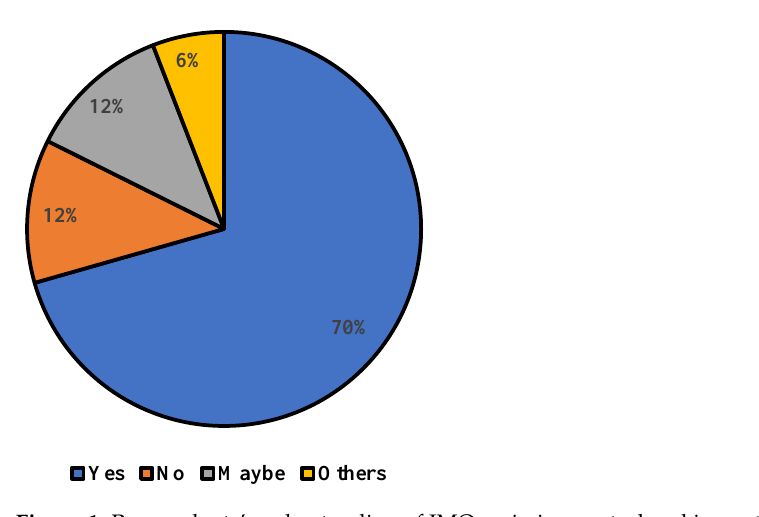
Figure 1. Respondents’ understanding of IMO emission control and impact.